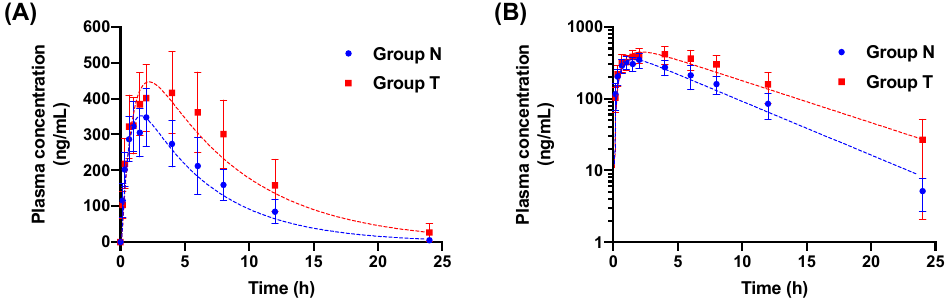
Figure 1. Plasma concentration-time profiles of tadalafil after oral administration to non-pretreated rats (Group N) and ticagrelor-pretreated rats (Group T). Values are represented as mean ± SD (n = 10). Dotted marks and dashed lines indicate the observed plasma concentration and the fitted pharmacokinetic profile from the one-compartment model, respectively. ( A ) Linear scale; ( B ) log scale. Table 1. Non-compartment analysis parameters of tadalafil after oral administration to non-pretreated rats (Group N) and ticagrelor-pretreated rats (Group T). Values are represented as mean ± SD (n = 10).